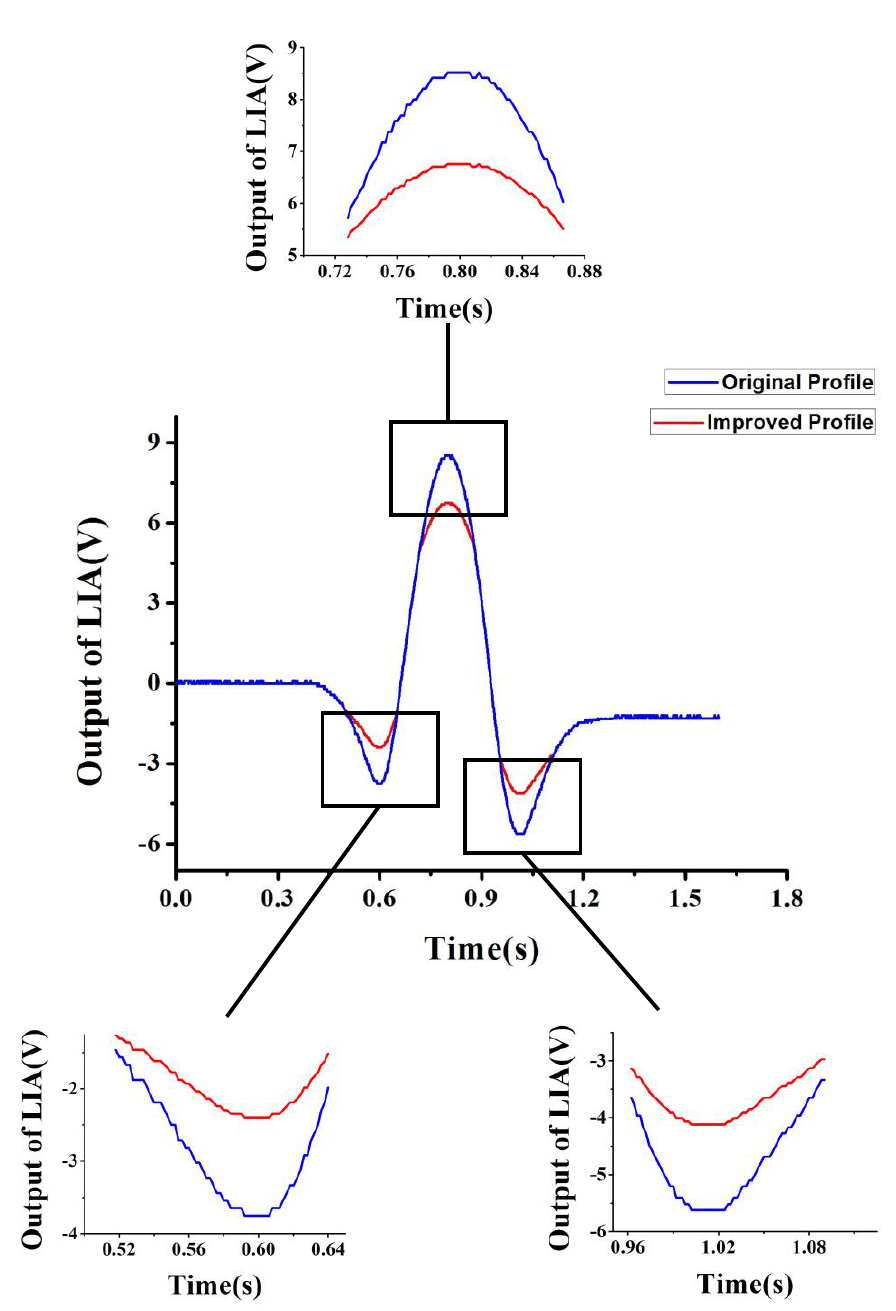
Figure 4. Original profile of the second harmonic (blue line) and the improved profile with modulation index adjustment (red line). Softer inflection points are shown in detail.